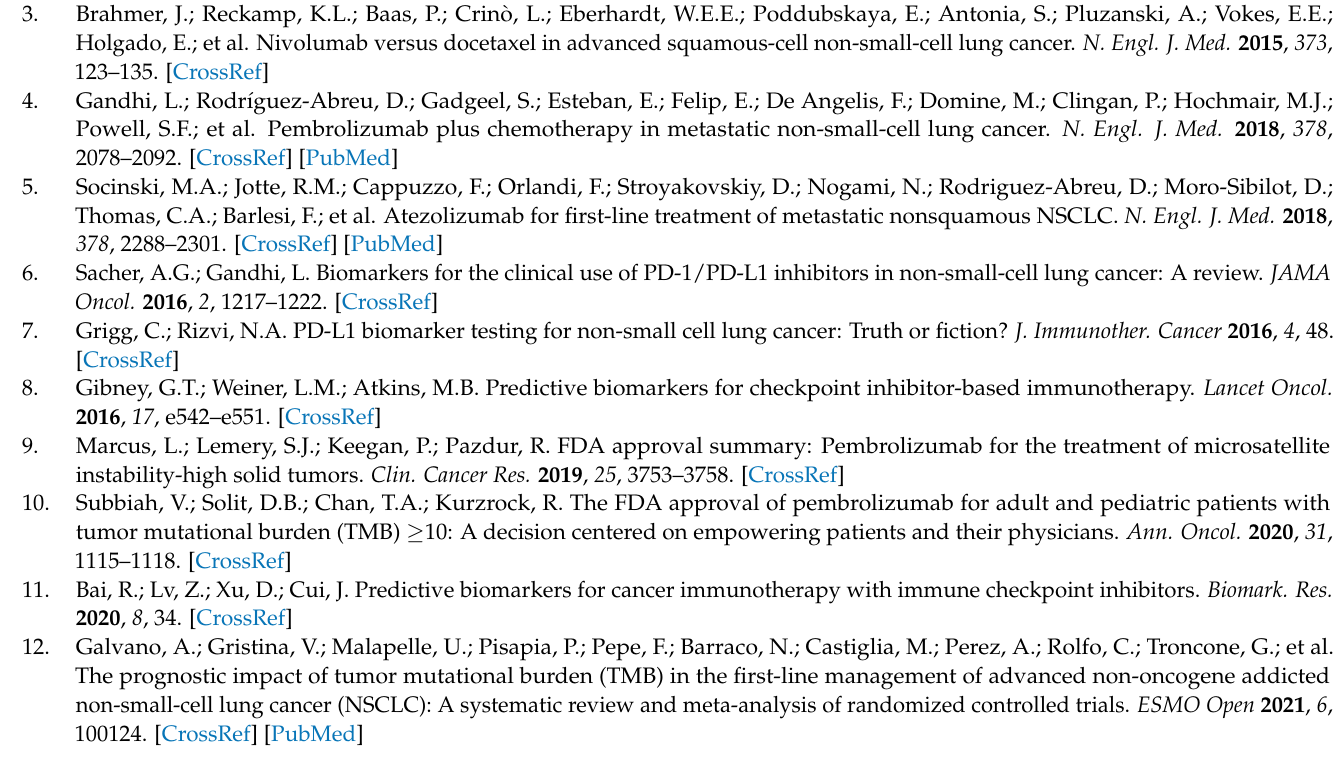
the study, Table S3: Comparison of TCR- β repertoire characteristics between PRE and FR samples, Table S4: Correlation of basal TCR- β repertoire characteristics with clinicopathological variables in pretreated NSCLC patients, Table S5: Correlation of TCR- β repertoire characteristics with response in NSCLC